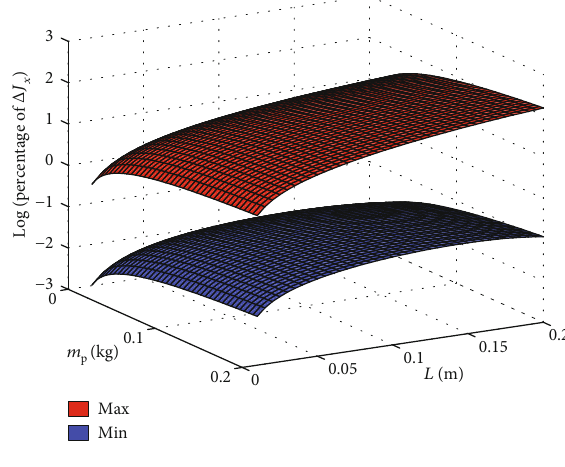
w : r : t : m and L variation. p x